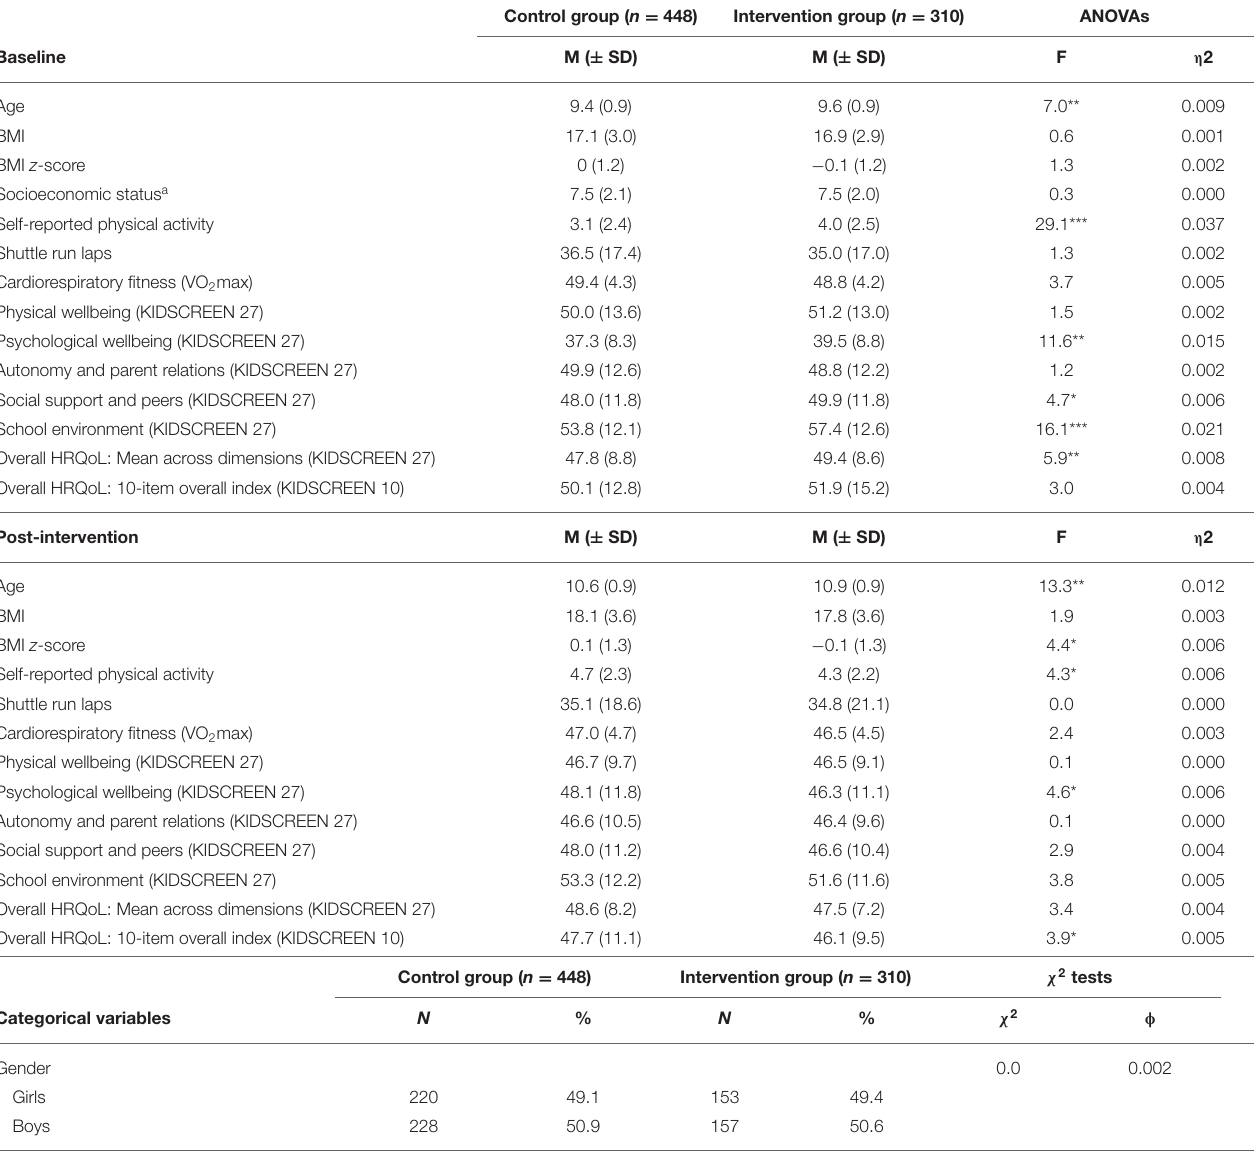
TABLE 2 | Means (M) and standard deviations (SD) at baseline and post-intervention in wellbeing, physical activity and cardiorespiratory fitness, and differences between intervention and control group. Control group ( n =